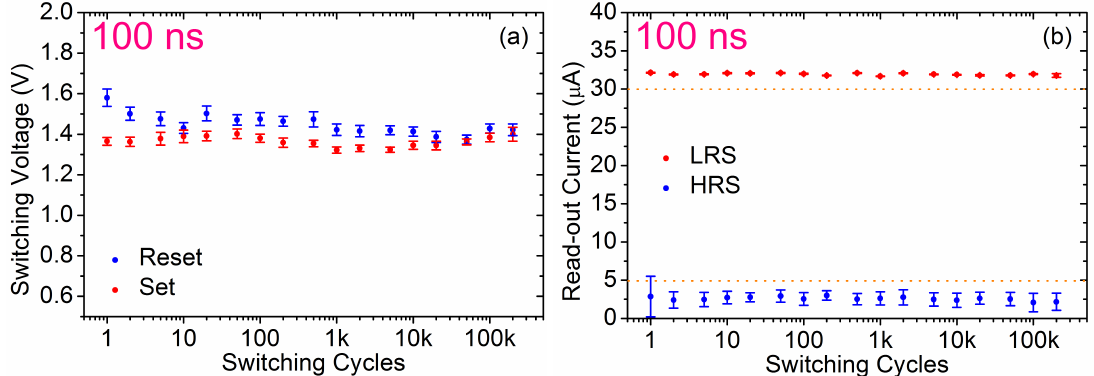
Figure 10. Mean and dispersion values of switching voltages ( a ) and of read-out currents ( b ) gathered just after the reset (blue) and set (red) transitions during an endurance test of 200k switching cycles on 128 RRAM devices by using a programming pulse width of 100 ns.